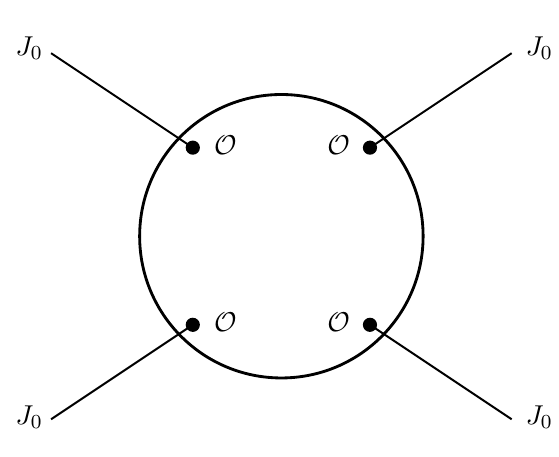
Figure 2 . Conformal four-point function h J 0 J 0 J 0 J 0 i in the critical boson theory obtained from Legendre transformation of the four-point function hOOOOi in the free boson theory. The enclosed part of the diagram represents the connected term of the correlator hOOOOi . There are